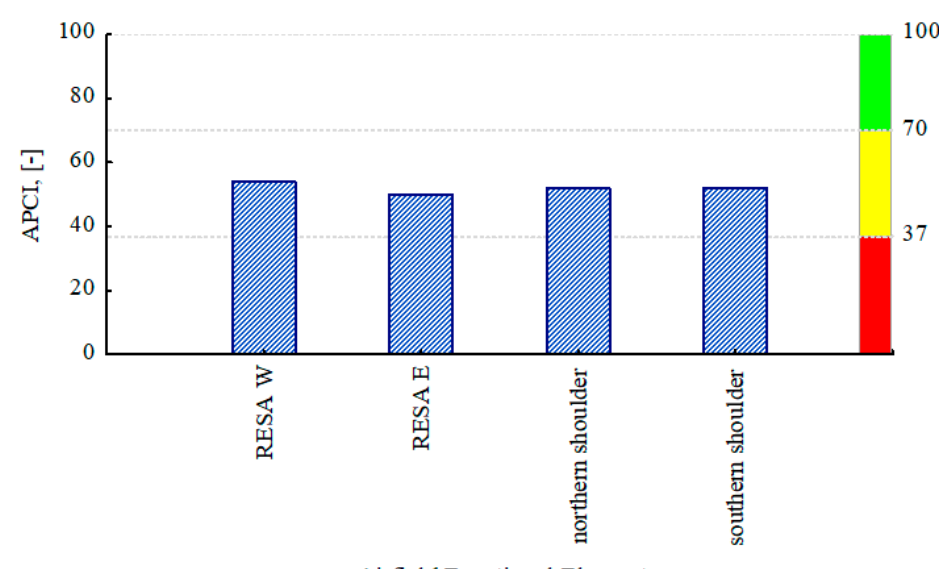
Figure 18. APCI NN values for natural AFE pavements.